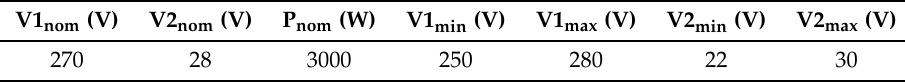
Table 3. Operating domain, based on MIL-704F standard [26] . Nominal conditions definition.